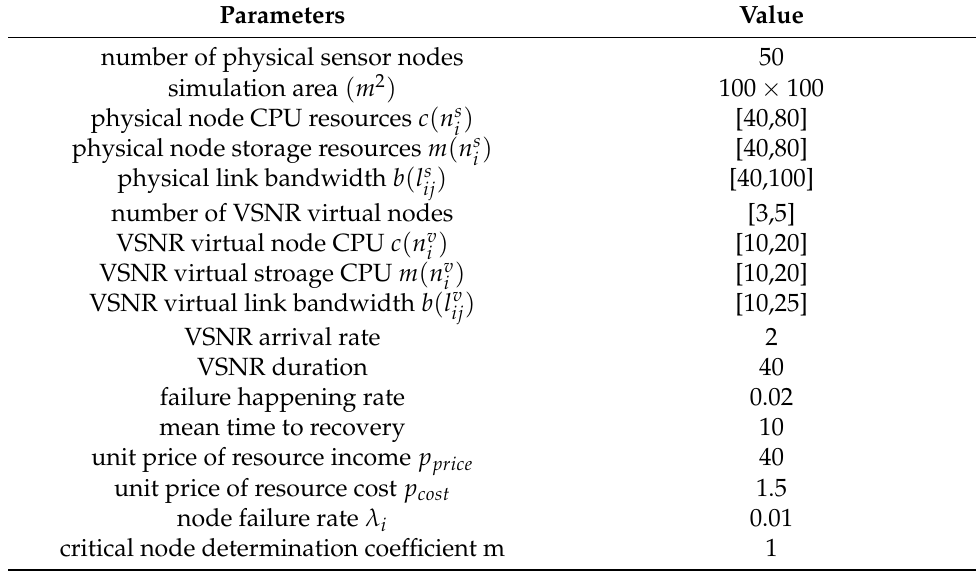
Table 1. Parameter settings.